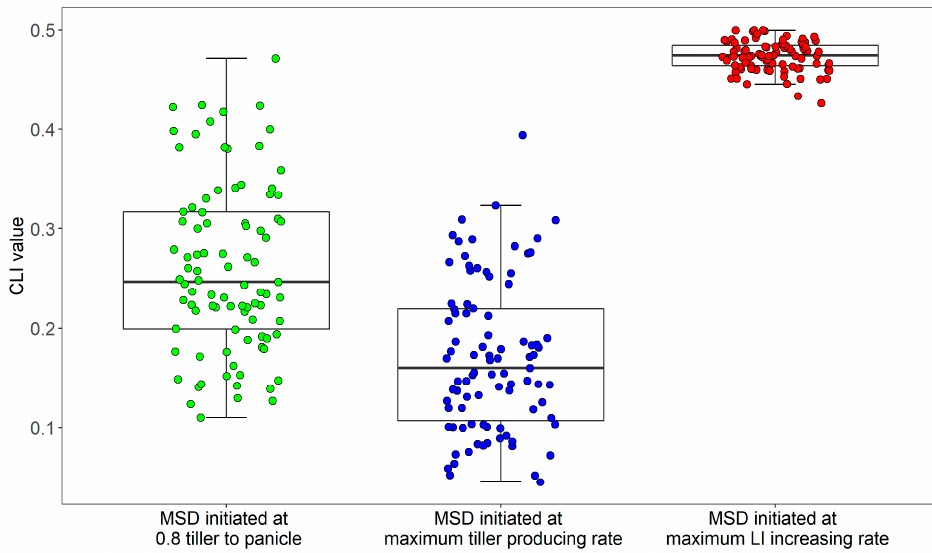
Figure 4. CLI values for different initiation criteria. Table 2. Summary statistics for the CLI value of MSD initiation of different criteria.